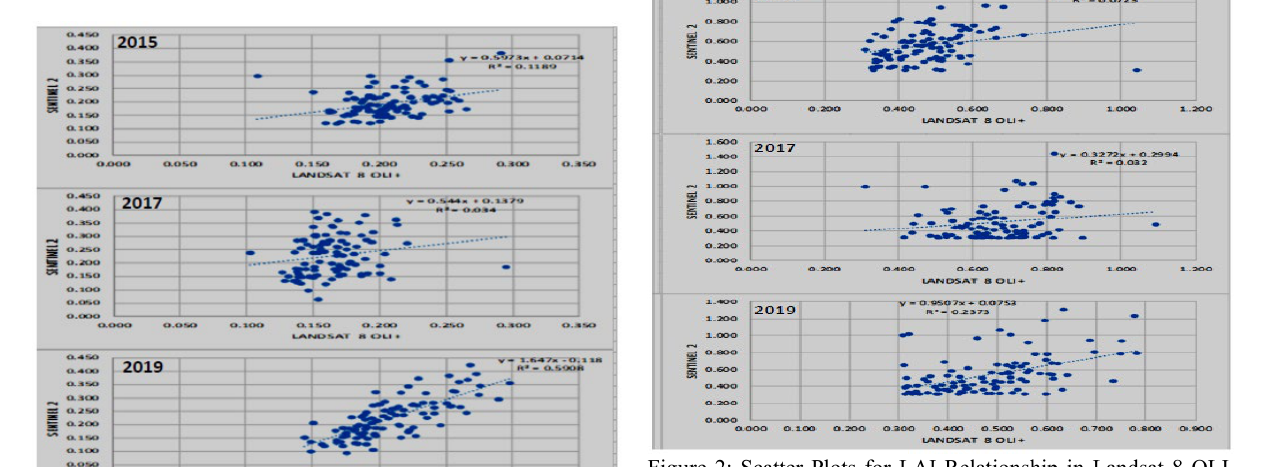
Figure 2: Scatter Plots for LAI Relationship in Landsat 8 OLI and Sentinel